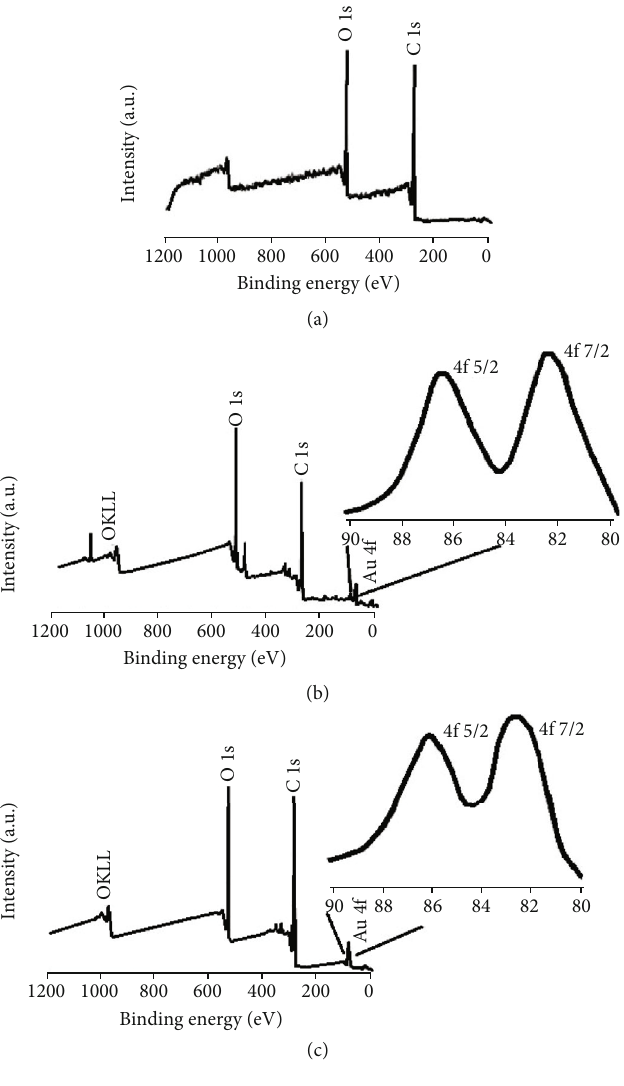
Figure 6: XPS spectra of (a) PET pristine, (b) PET-3Au, and (c)